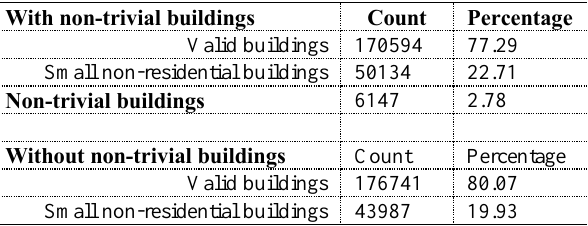
Table 5. Summary of the building distribution after processing The C5 decision tree (DT) classification algorithm, belonging to the supervised-learning family, was applied for buildings classification. Classification rules were created by using the algorithms on the various variables calculated for building features. The level 1 buildings classification results are given in Table 6. The largest group of buildings (44.72%) in Manchester is semi-detached houses followed by terraced housing, 41.68% (end-terraced plus mid-terraced buildings). The smallest group, 5.72%, of residential buildings is detached houses; Group 5 (7.88%) comprises of complex buildings. A classification sample map is sown in Figure 3.